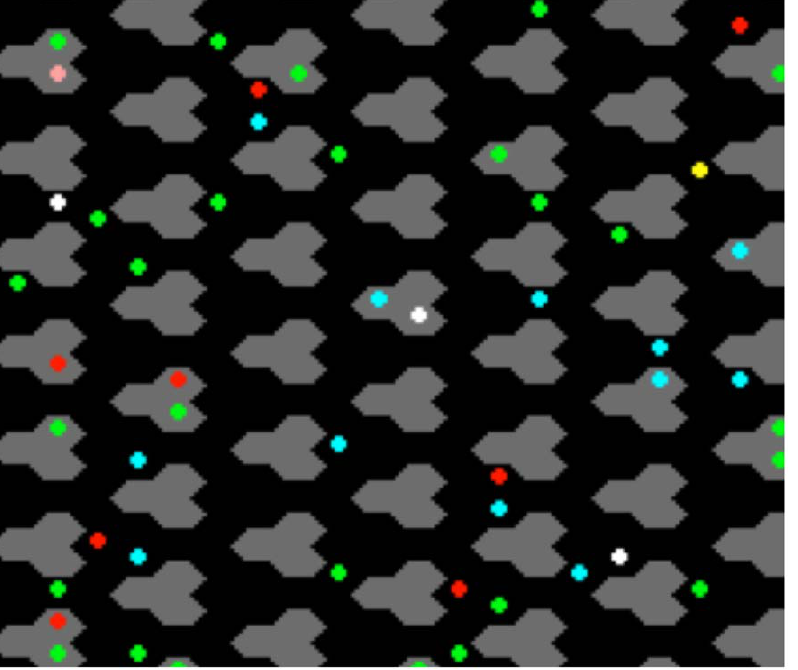
Figure 2. Example simulation. Receptor trimers (gray) arrayed on a hexagonal lattice, with soluble proteins (colored dots) able to move around on top of the array, and to stochastically bind to one another or transfer state information such as phosphorylation/methylation status.